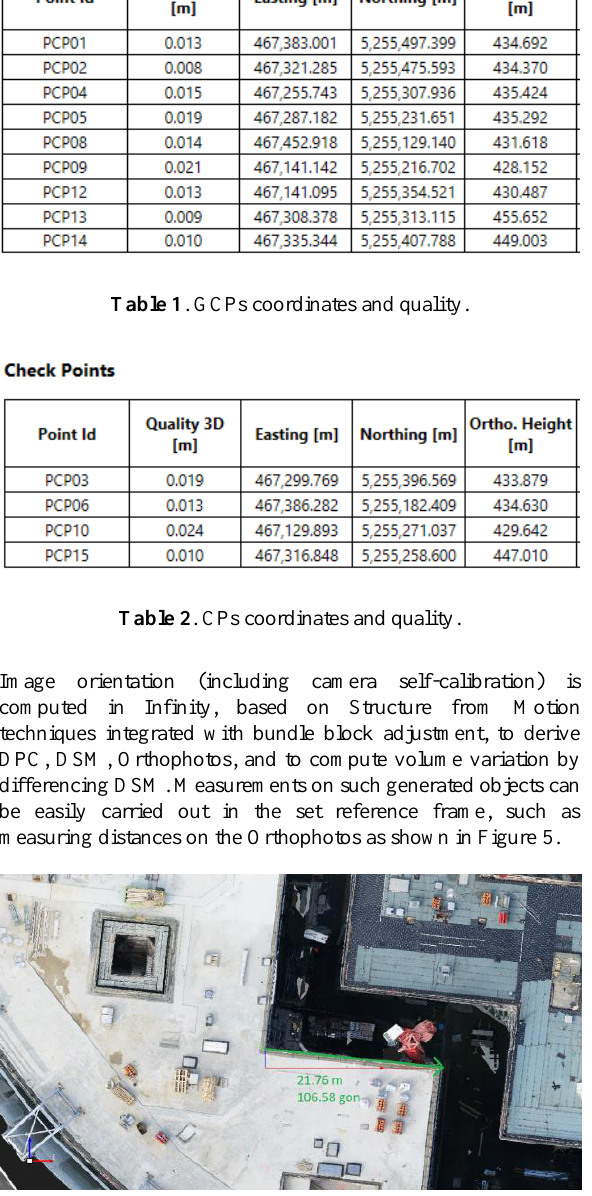
Figure 5 . Zoom on generated orthophoto. Distance can be easily computed defining start and end points.